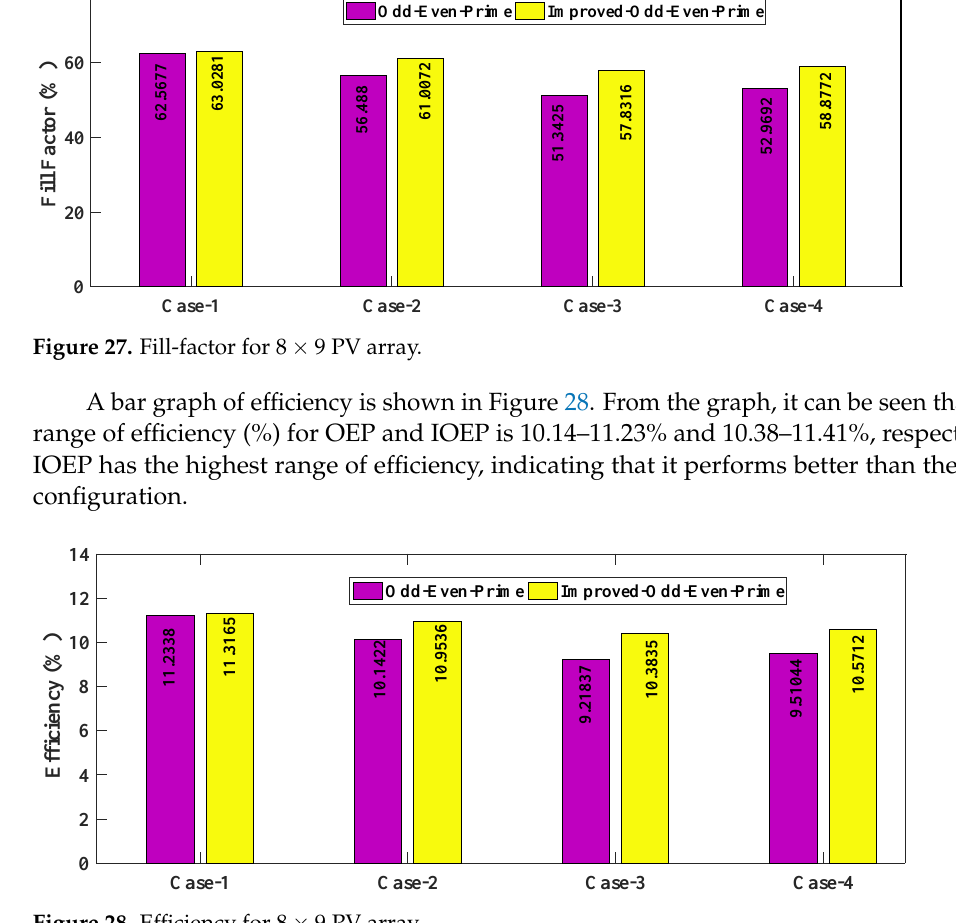
Figure 28. Efficiency for 8 × 9 PV